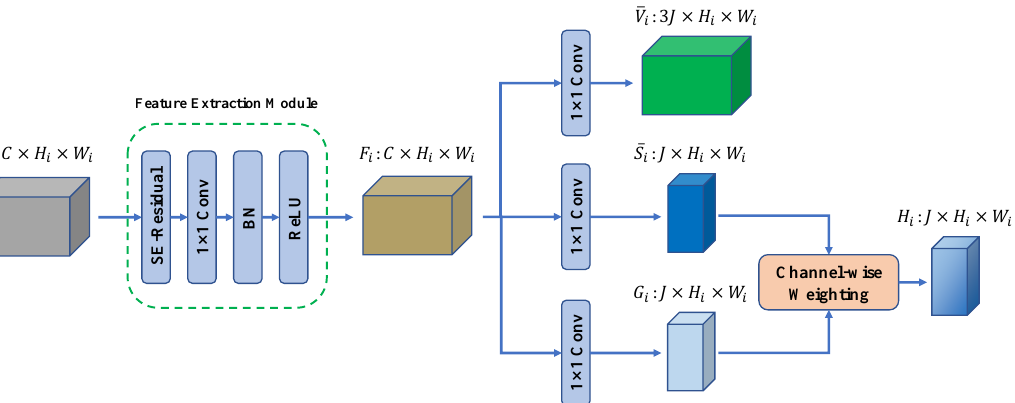
Figure 3. Illustration of the dense extraction module at stage i . The feature extraction module consists of a SE-Residual block, a Conv layer, a batch normalization (BN) layer, and a ReLU activation function. V i and S i are the two parts of the predicted 3D offset map, and S i and G i form the shifted attention heatmap. C i , H i , and W i are the number, height, and width of the feature maps at stage i . In our implementation, C i = C , H i = H , and W i = W for i = 2 2